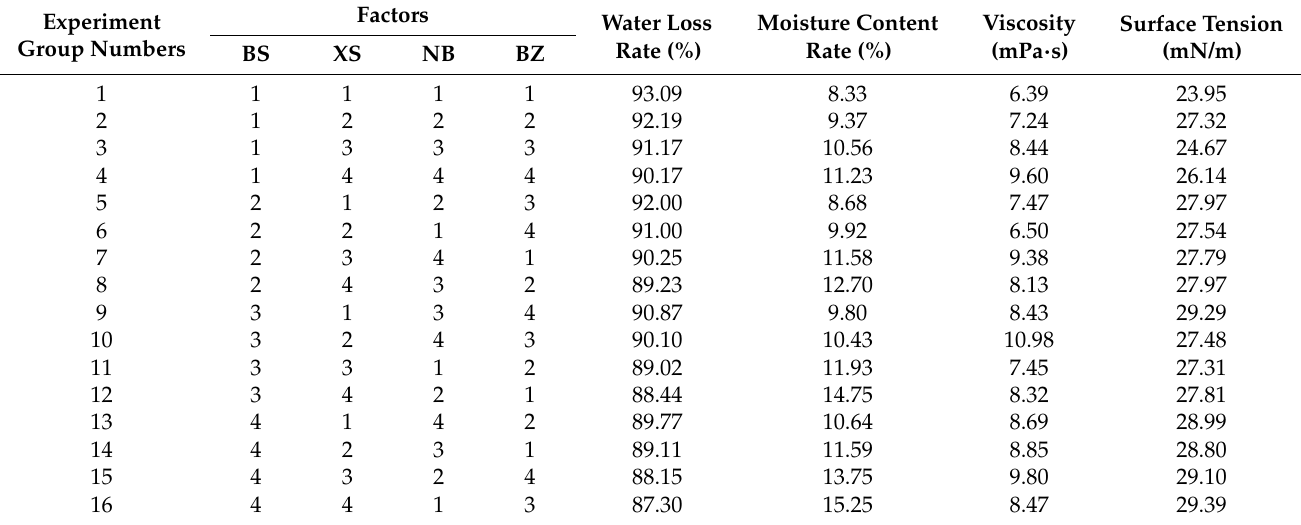
Table 3. Data from orthogonal